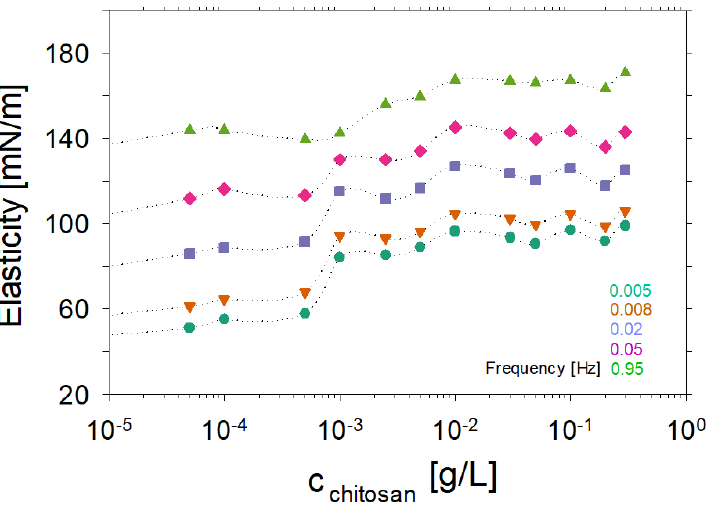
Figure 7. Surface dilational elasticity results as a function of chitosan concentration in aqueous mixtures with saponin 0.1 g/L and acetic acid 0.1 wt% (pH 3.4). Plots for five various oscillation frequencies, which were 0.005, 0.008, 0.02, 0.05 and 0.95 Hz, as indicated in the figure, are